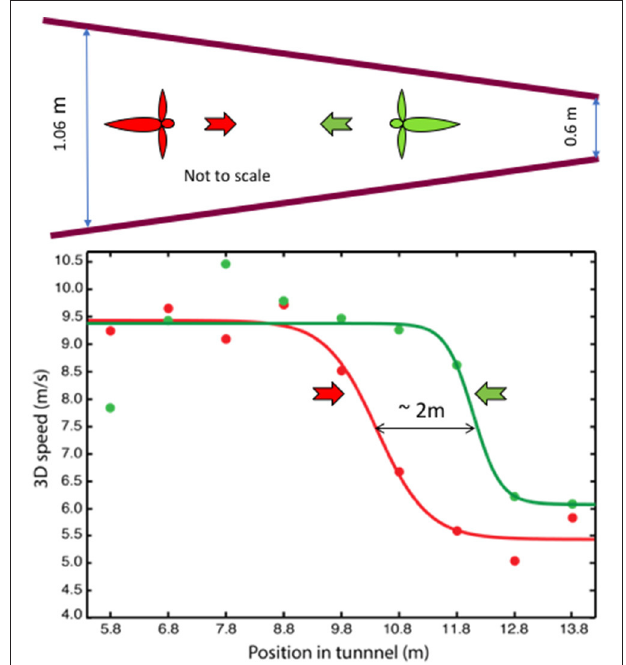
FIGURE 3 | Profiles of flight speed of Budgerigars in a tapered tunnel, of height 2.4m, during flight in the narrowing direction (red) and in the widening direction (green). Adapted with permission from Schiffner and Srinivasan (2016), which provides further information and statistical analyses of the